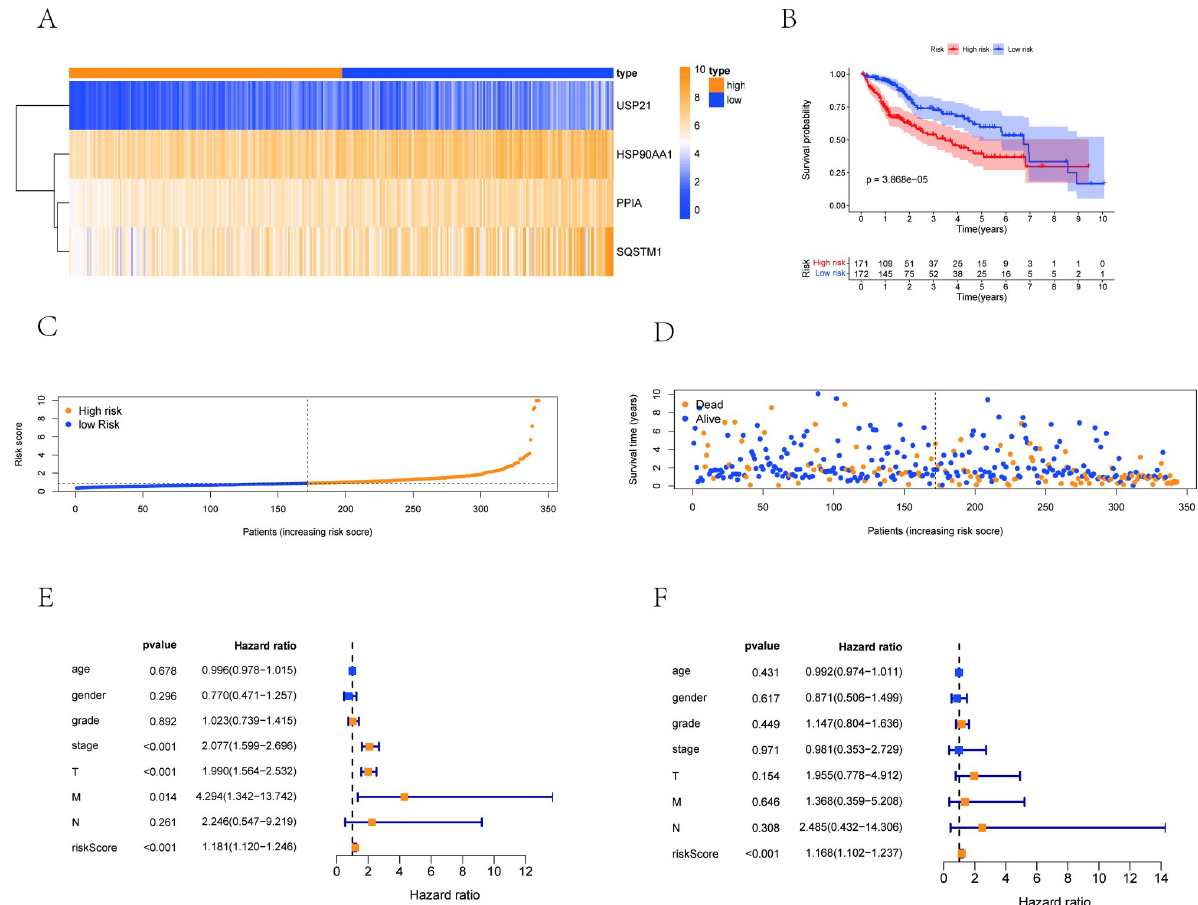
Fig 3. Development of a prognostic index based on NRGs. (A) Heatmap of the expression profile of 4 NRGs (HSP90AA1, PPIA, SQSTM1, USP21). (B) Survival status of patients in the high-risk and low-risk groups. (C) Distribution plot of the risk score of patients. (D) Distribution plot of the survival status of patients. (E, F) The forest plot of univariate and multivariate Cox regression analysis in